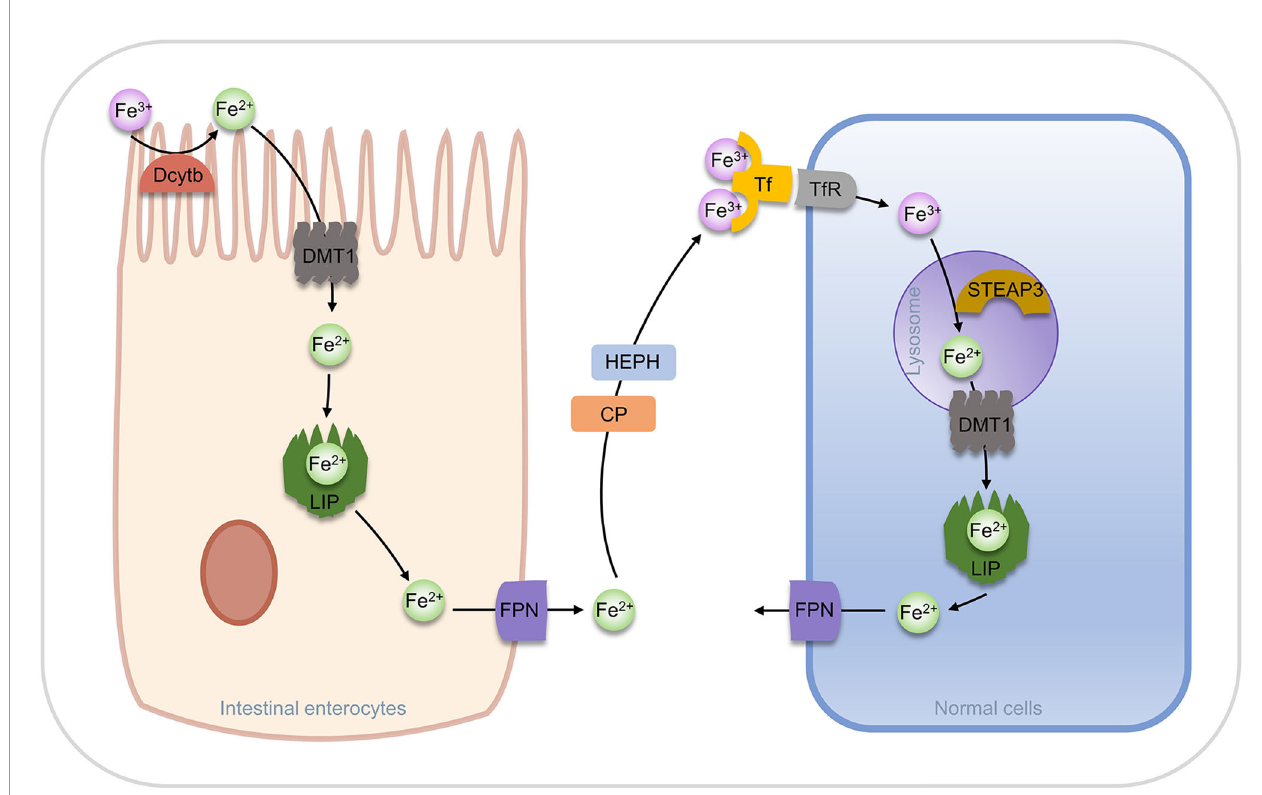
FIGURE 3 | Regulation of iron transport in vivo